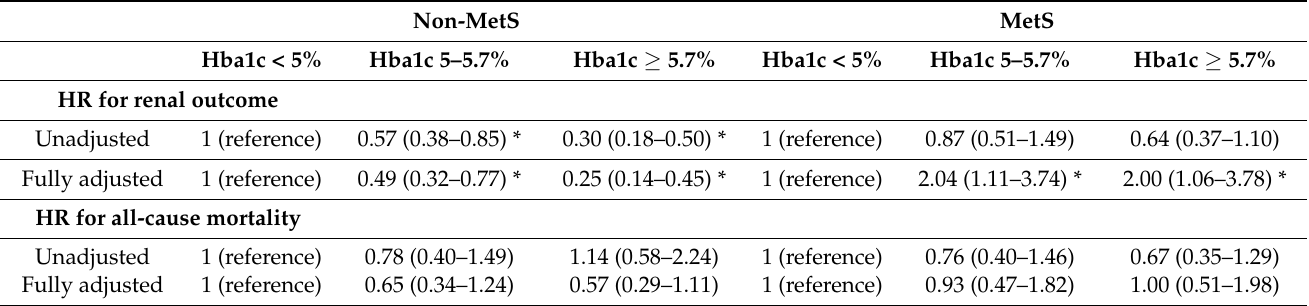
Table 4. Association between HbA1c and clinical outcome with or without metabolic